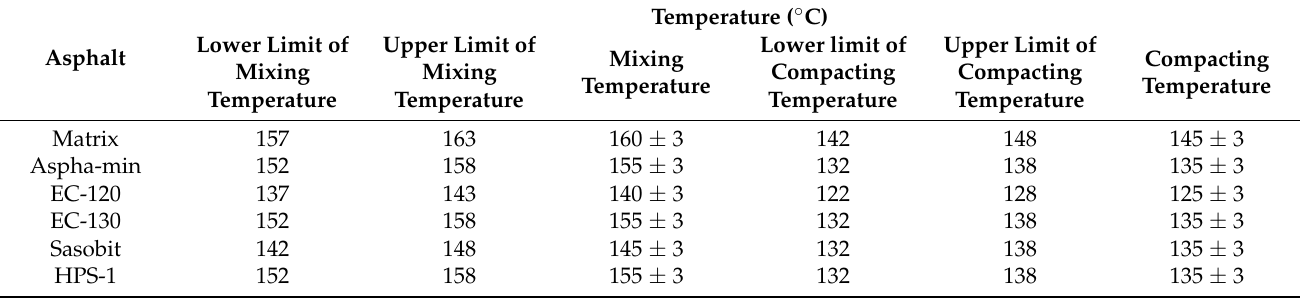
Table 9. Mixing and compaction temperature of asphalt.